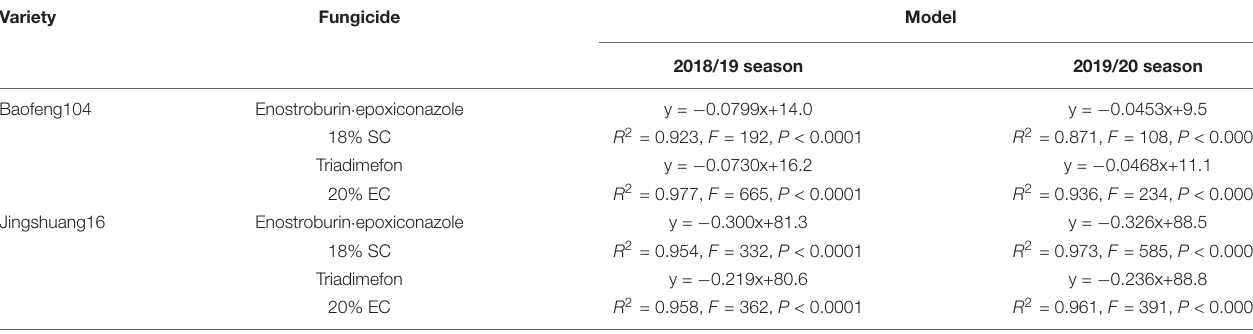
TABLE 6 | The relationship models between disease indexes and active ingredient dosages of two fungicides on different varieties in two growing seasons. Variety Fungicide